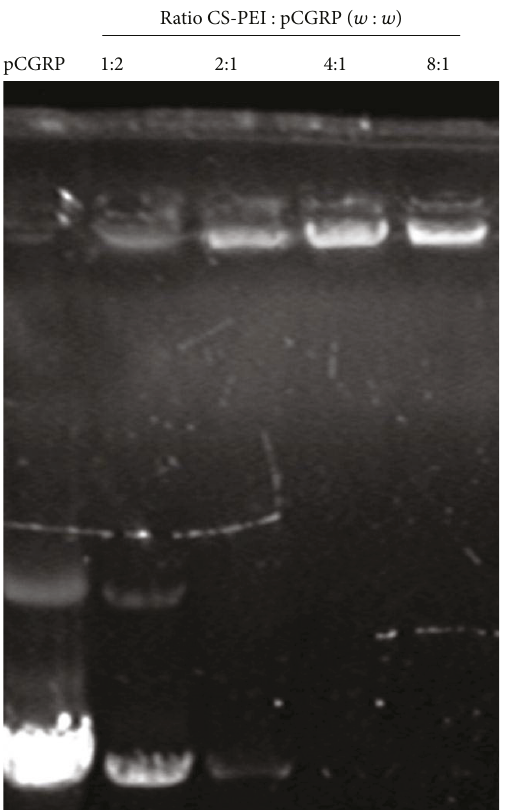
Figure 4: DNA binding capacity of CS-PEI in agarose gel retardation assay.